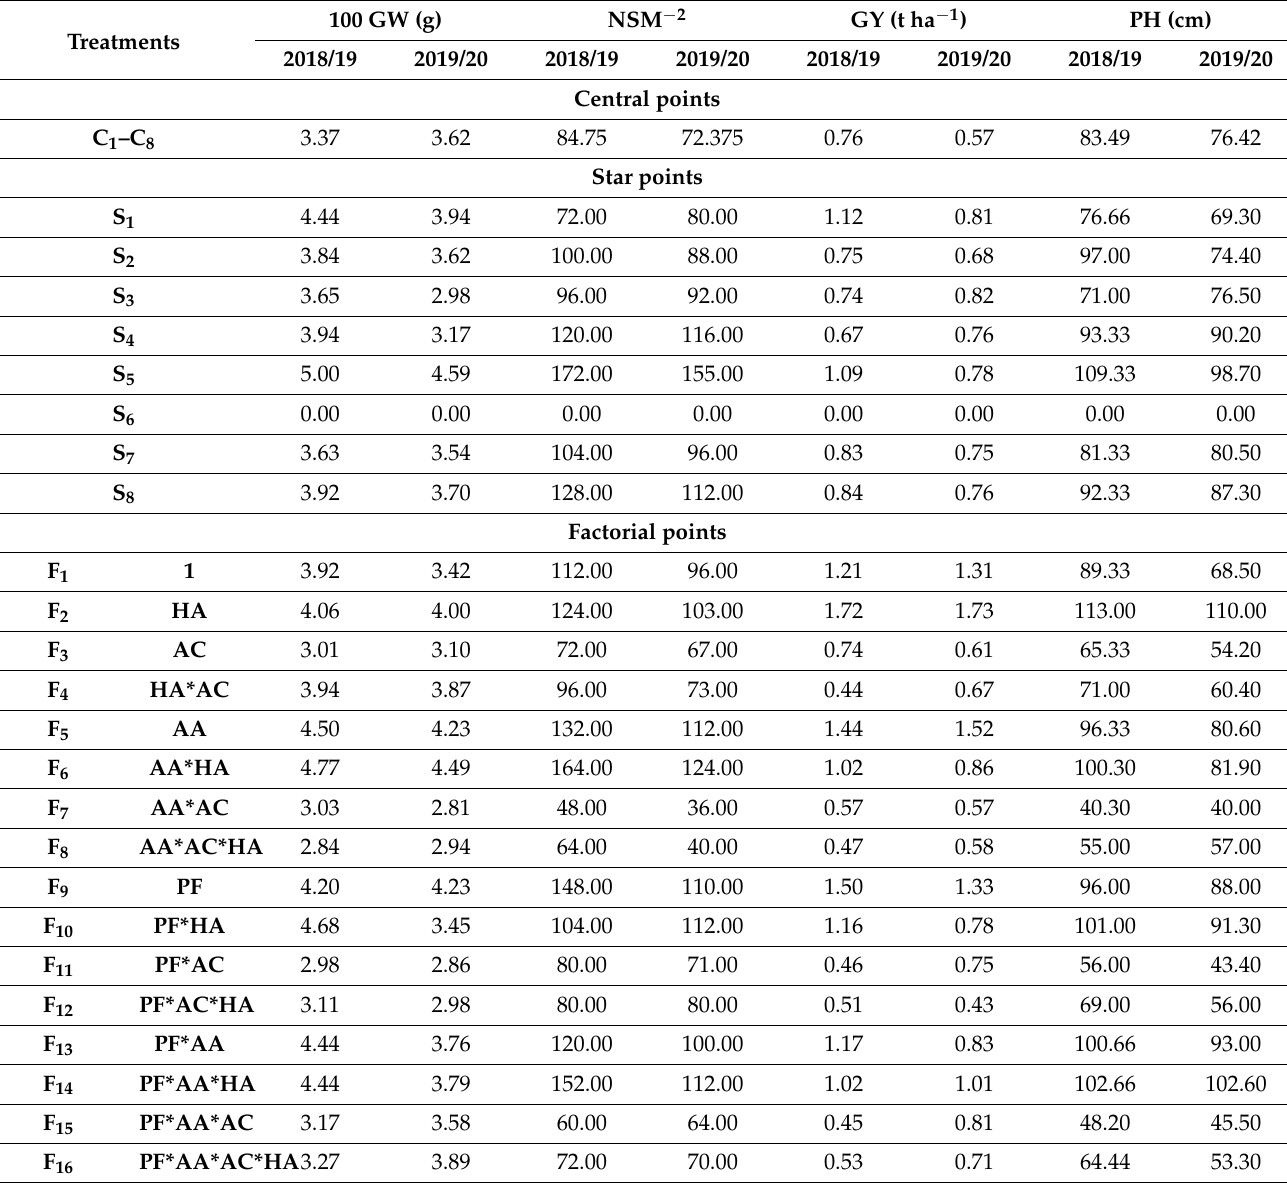
Table 9. Values of 100-grain weight, number of spikes m − 2 , grain yield and plant height, as affected by the levels of PF, AA, AC and HA and their interactions in 2018/19 and 2019/20.